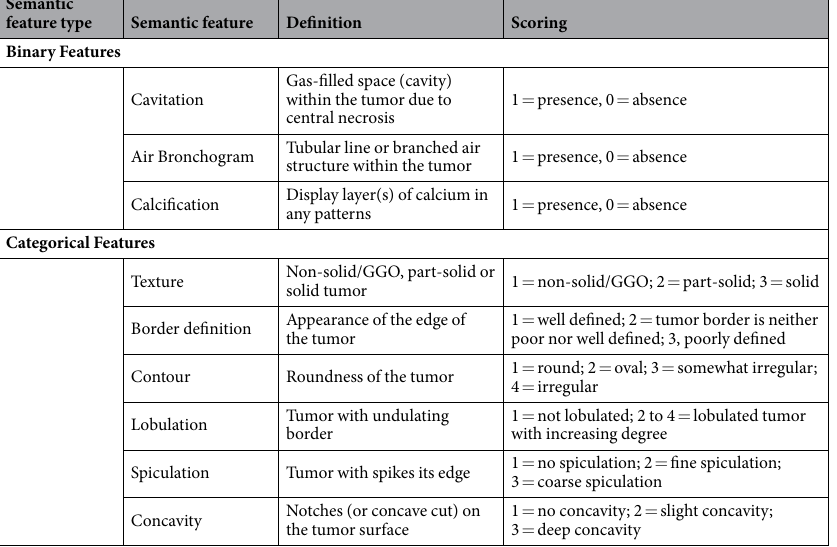
Table 2. Definition of the CT-based semantic features for lung tumor. Visual examples of tumors with different semantic features are shown in the supplemental